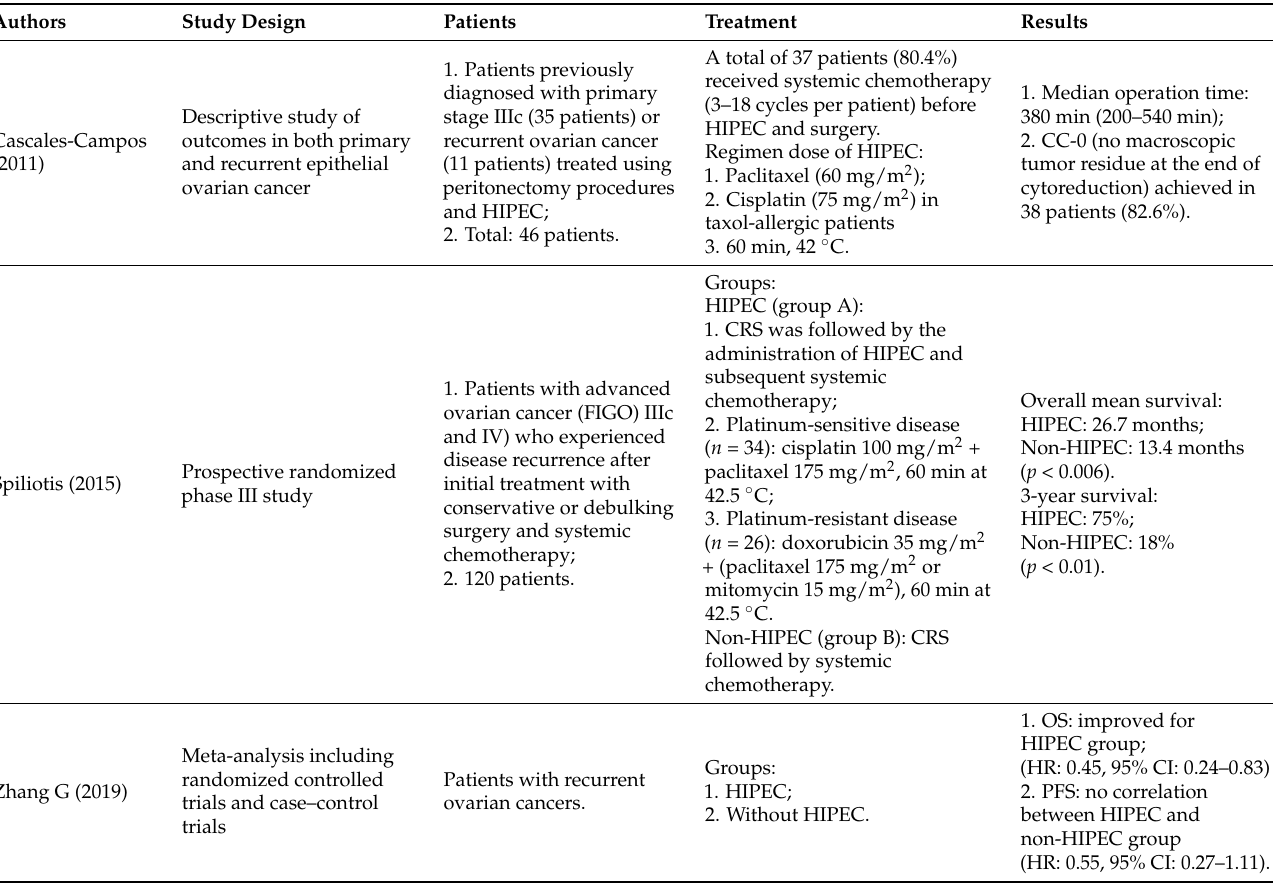
Table 3. A summary of clinical studies investigating HIPEC treatment for recurrent ovarian